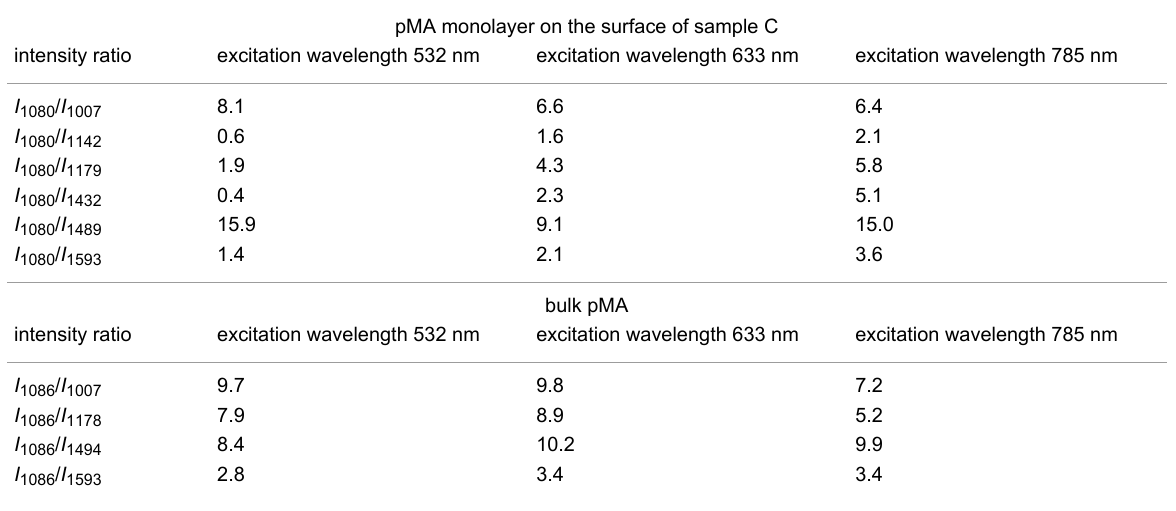
Table 3: Comparison of the intensity ratio of selected peaks in the Raman spectrum of bulk pMA and SERS spectrum of pMA monolayer on the sur- face of sample C.